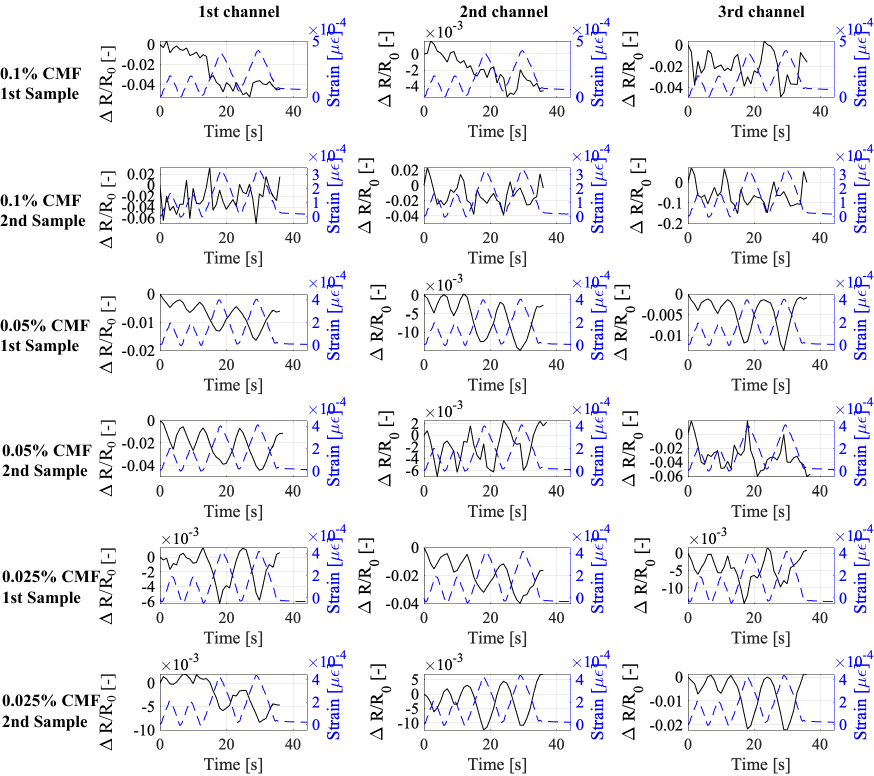
Figure 7. The measured signals from the beam samples; rows contain signals from each sample, and columns contain the data obtained through measurement channels 1, 2, and